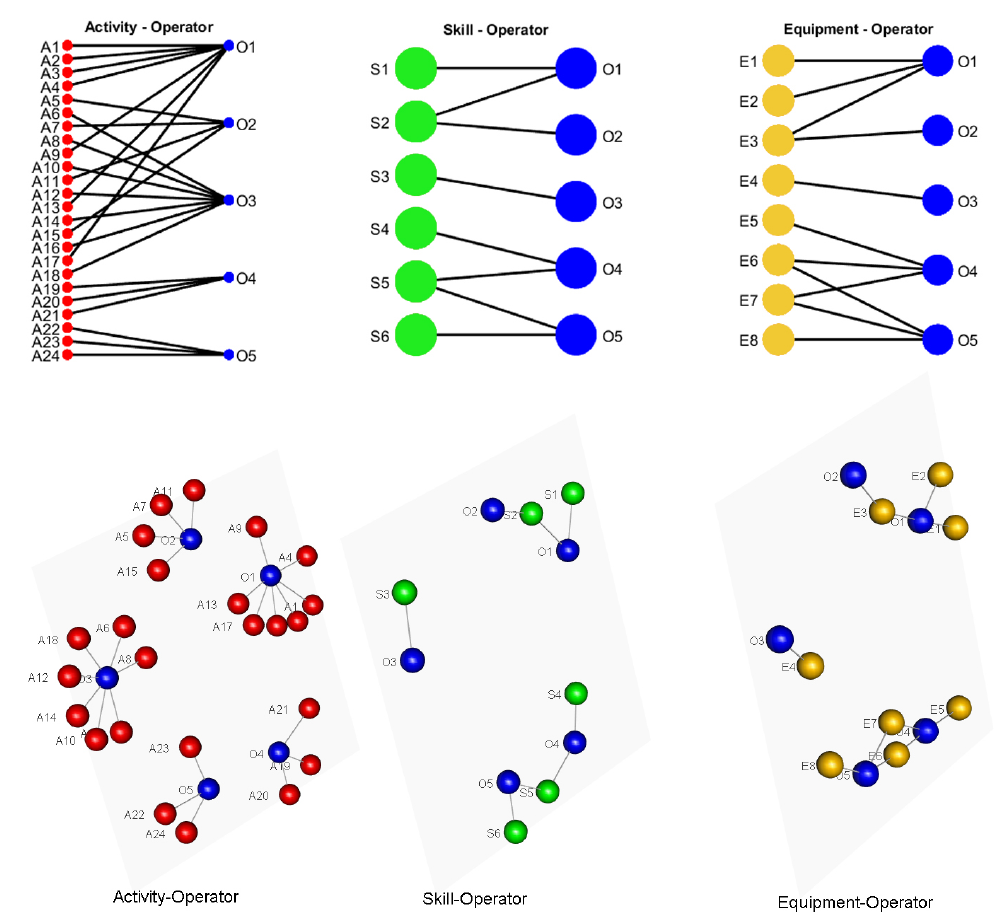
Figure 5. Illustration of the skill–operator and equipment–operator assignments after line